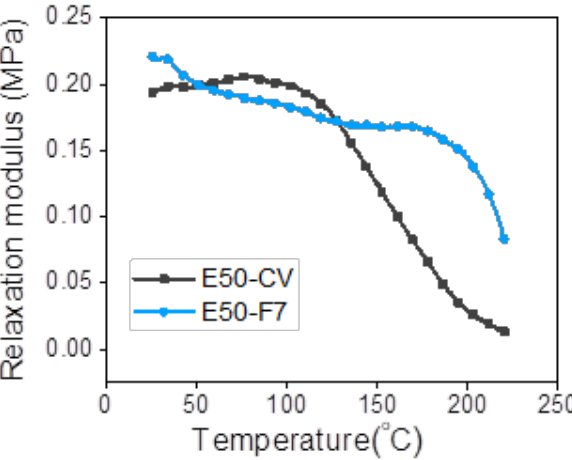
Figure 8. Representative relaxation modulus of ENR-50 compounded with 7 mmol of FeCl 3 (E50-F7) and the conventional sulfur vulcanizate (i.e., E50-CV). Table 6. Degradation temperature (T d ) of the neat ENR-50 and ENR-50 compounded with various concentrations of FeCl 3 and the conventional sulfur vulcanization (i.e., E50-CV).